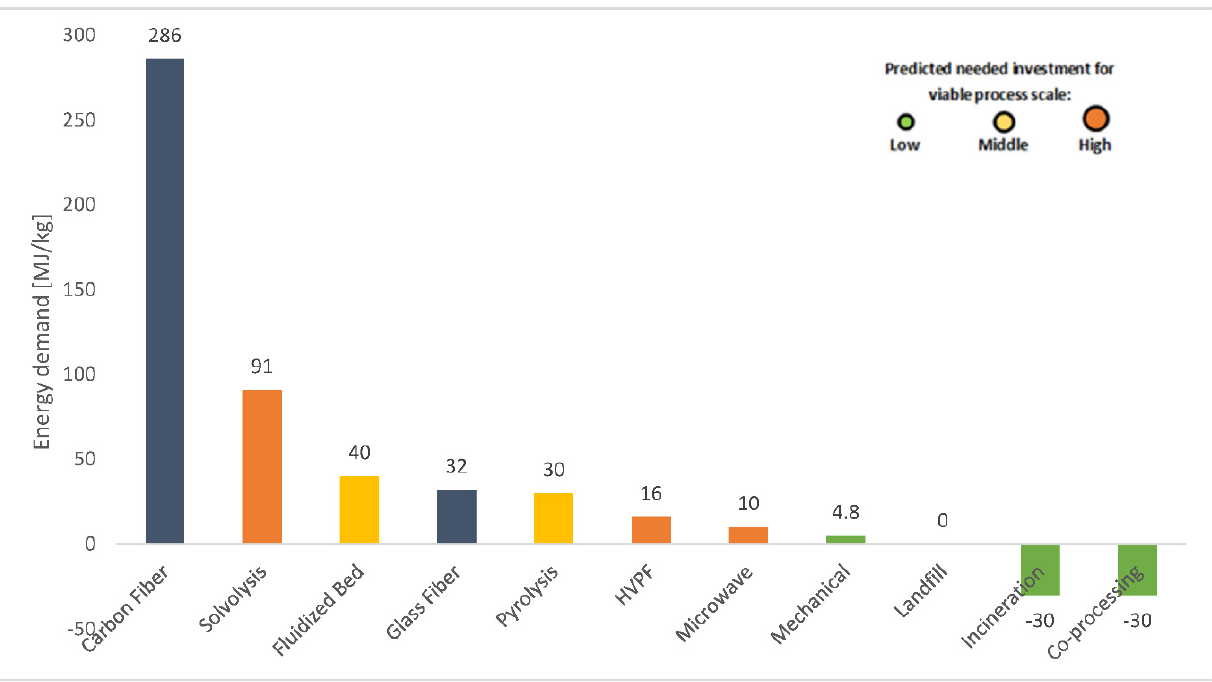
Figure 4. Energy demand for the different methods and for producing virgin fibers .